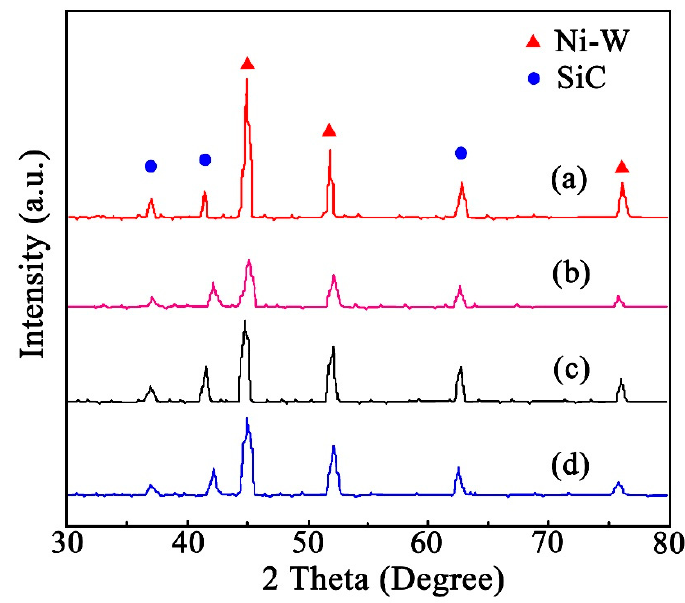
Figure 5. XRD spectrograms of ( a ) S1, ( b ) S2, ( c ) S3, and ( d ) S4 nanocomposites.